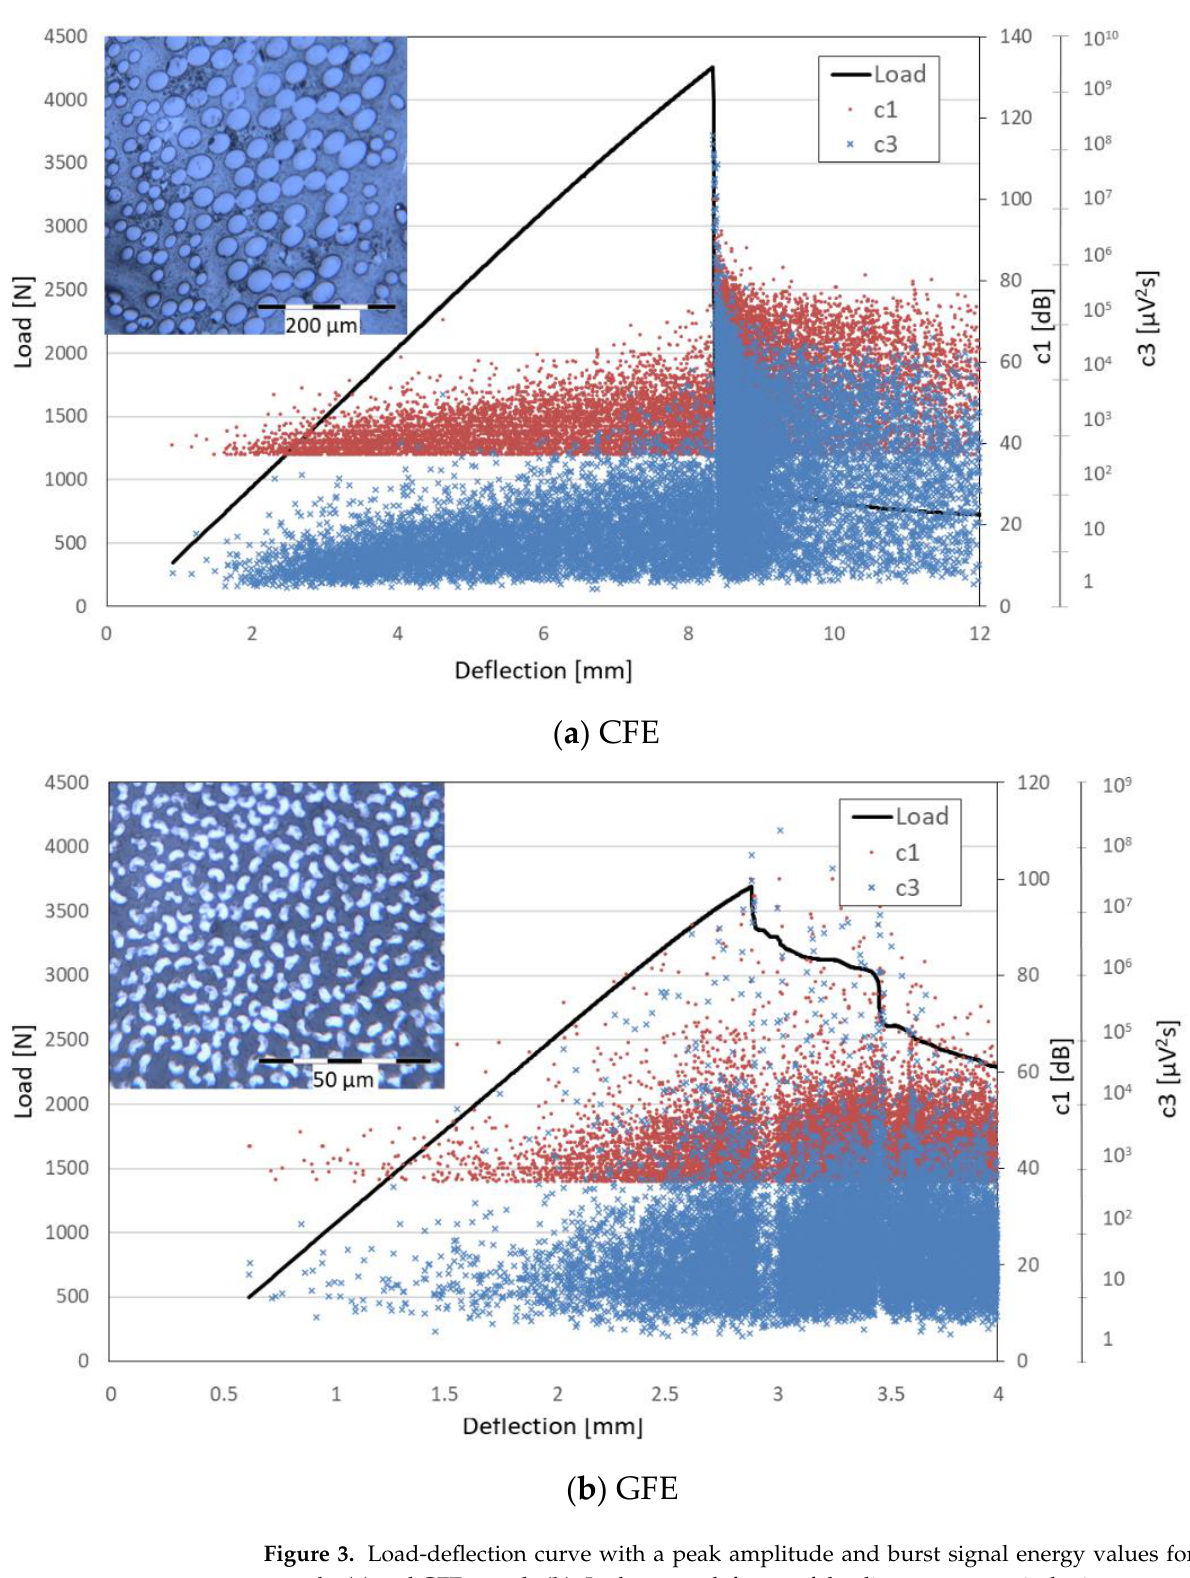
Figure 3. Load-deflection curve with a peak amplitude and burst signal energy values for CFE sample ( a ) and GFE sample ( b ). In the upper left part of the diagrams are optical microscope photos of the sample cross-sections.